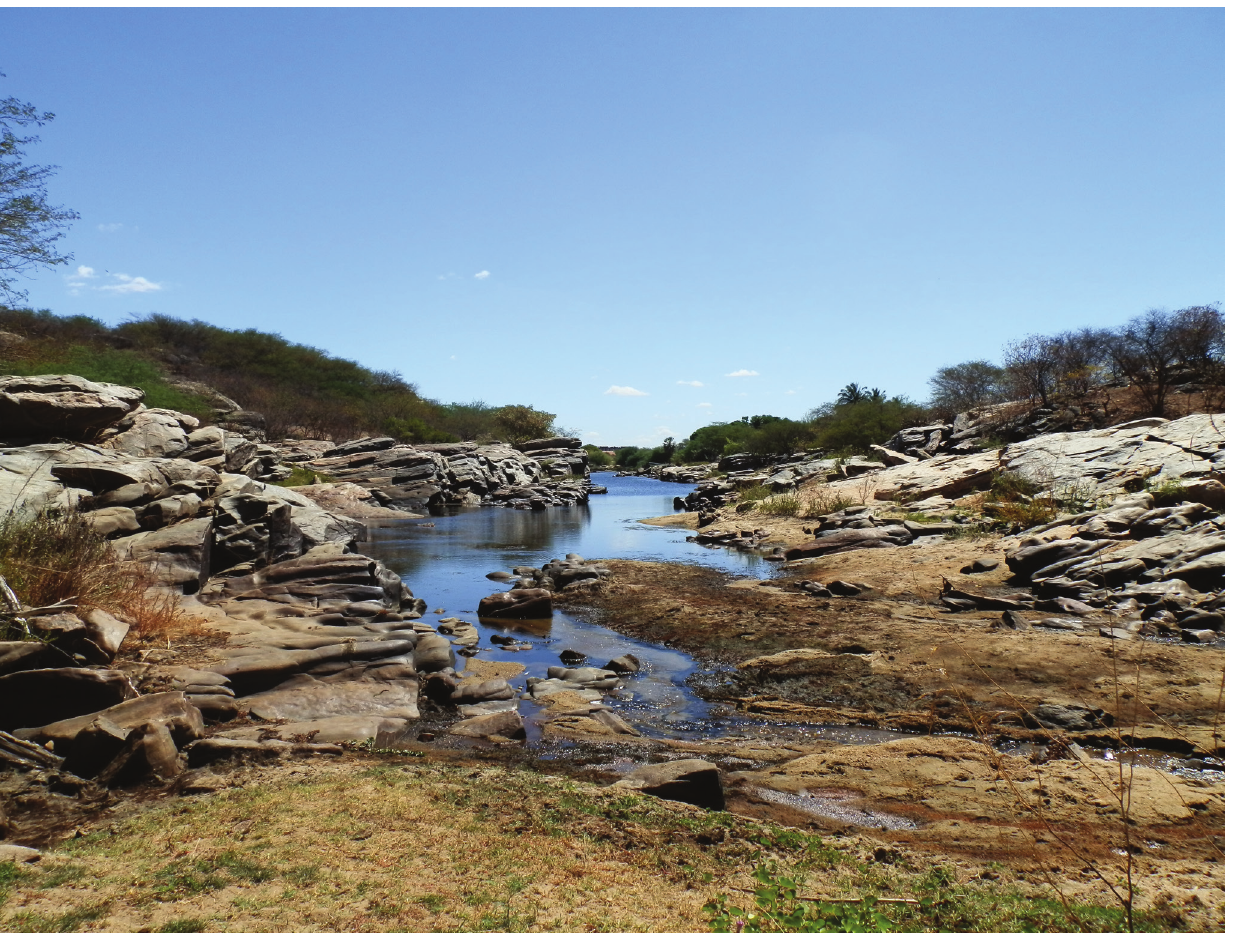
Fig. 6. Type locality of Parotocinclus seridoensis , Brazil, Rio Grande do Norte State, Caicó, rio Seridó, rio Piranhas-Açu